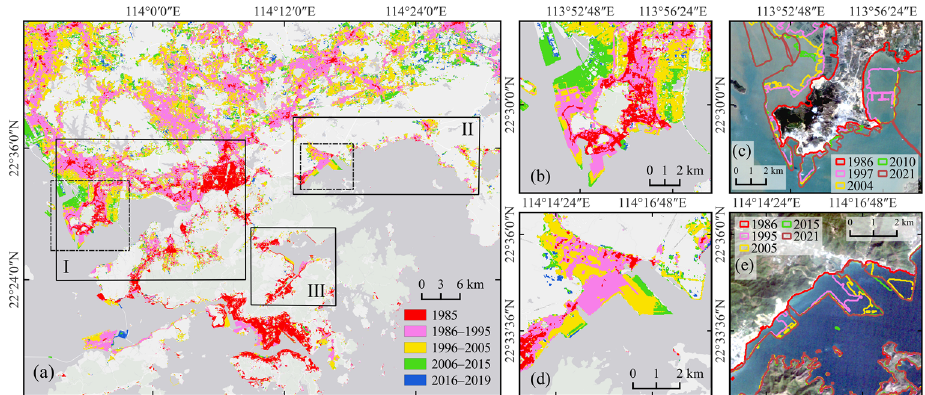
Figure 6. Spatiotemporal changes of impervious surface areas (ISA) and coastlines. ( a ) Location of the monitoring areas ( I , II and III ). ( b , c ) Shekou Peninsula. ( d , e ) Yantian Port.